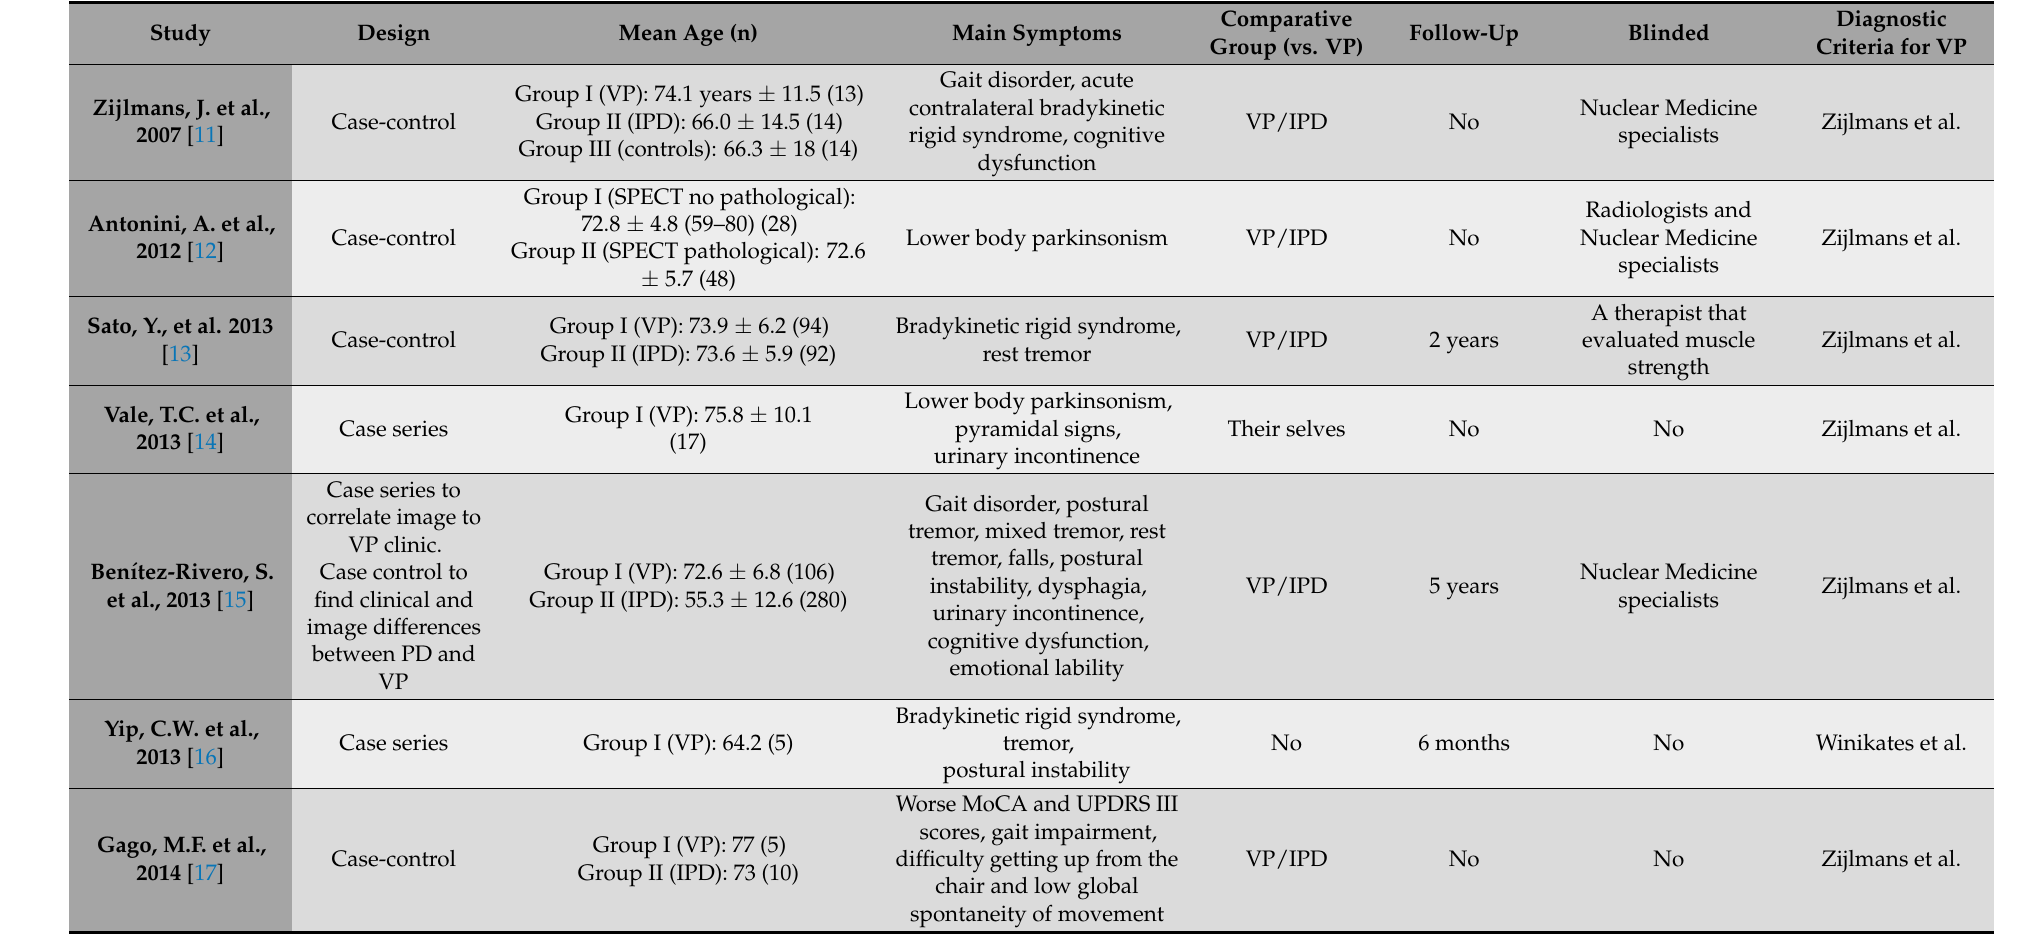
Table 1. Studies methodology and clinical-demographic